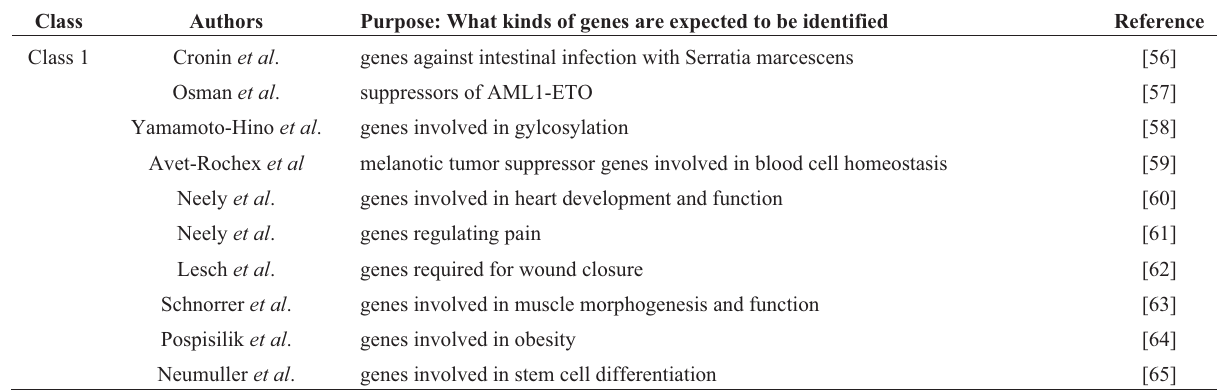
Table 2. In vivo RNAi screens in Drosophila